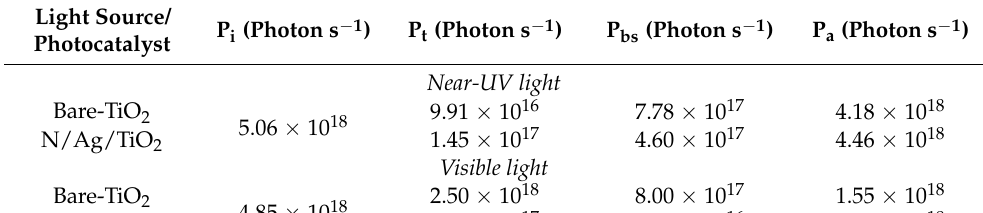
Figure 4 reports the photon absorption efficiency of near-UV light and visible light irradiation calculated from the ratio of absorbed photons by the photocatalyst over the irradiated photons reaching the photocatalyst surface.